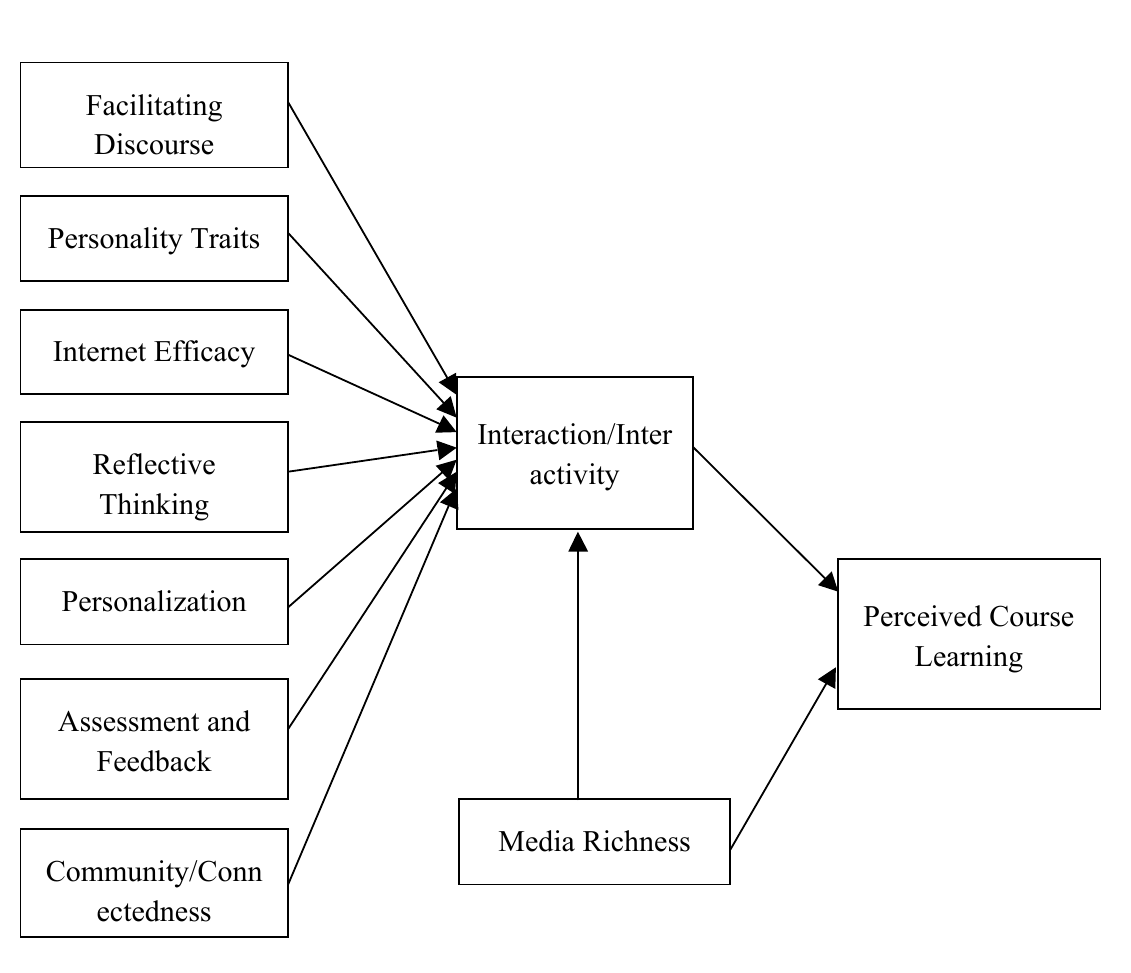
Figure1. Conceptual framework of the study